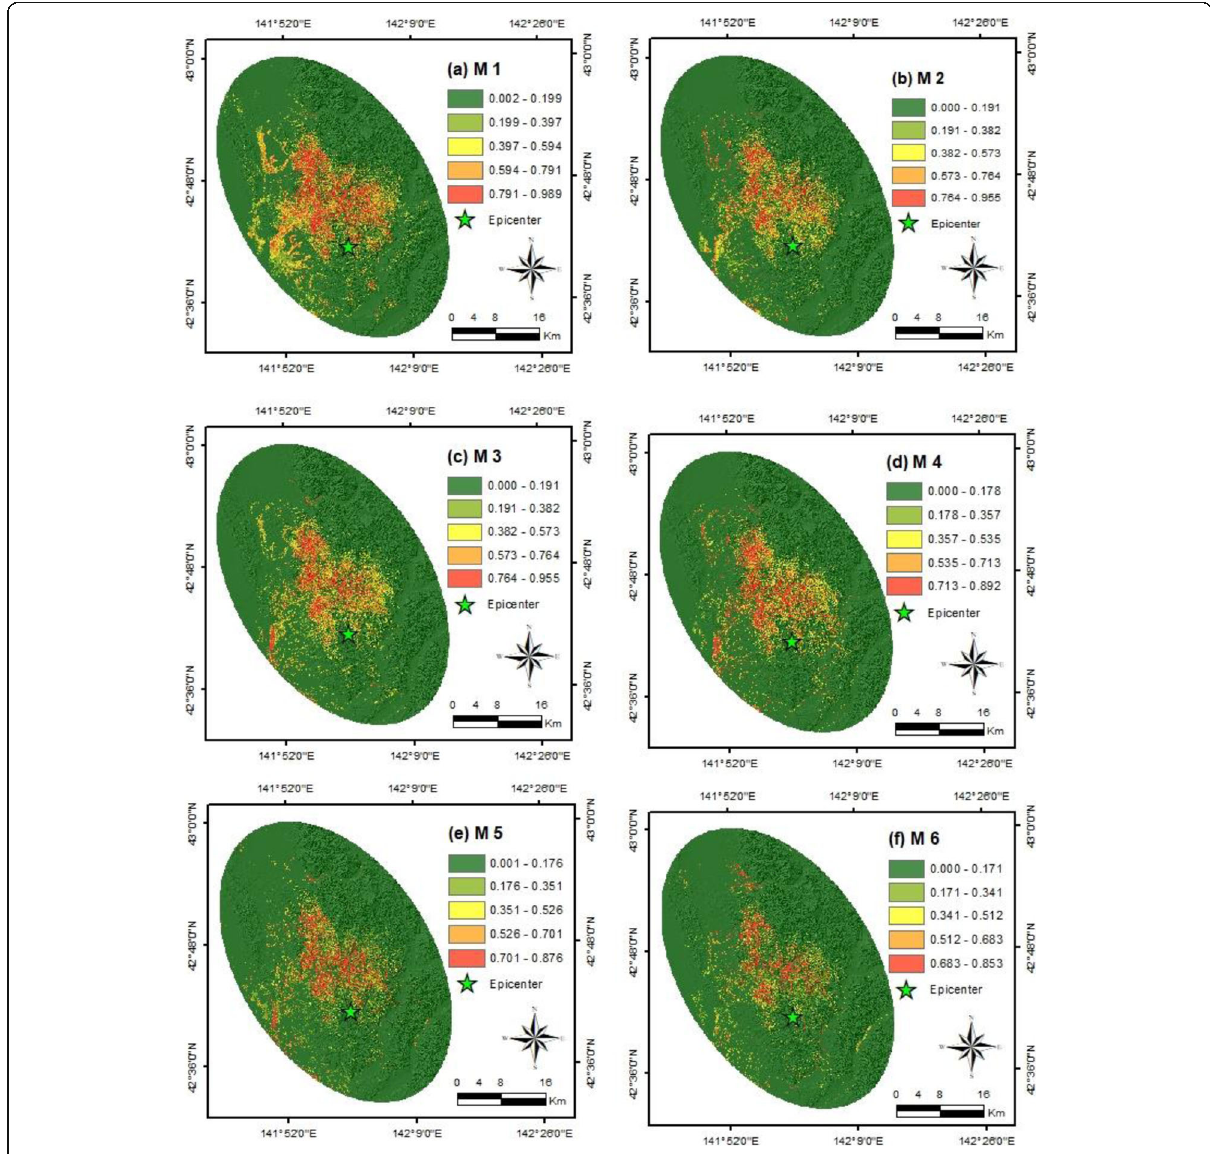
Fig. 6 Landslide susceptibility assessment on sampling strategies of non-landslide points randomly generated in the mountainous only zone (M): a M 1, b M 2, c M 3, d M 4, e M 5, and f M